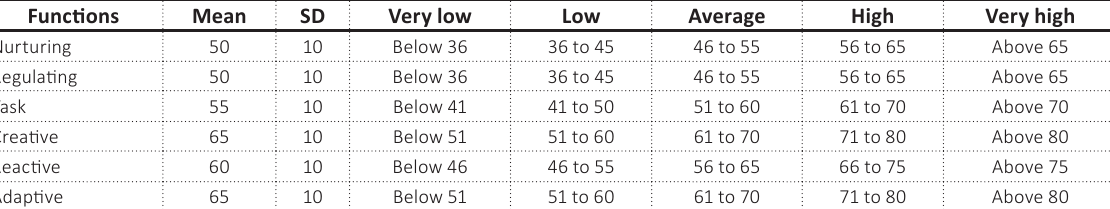
Source: Pareek and Purohit